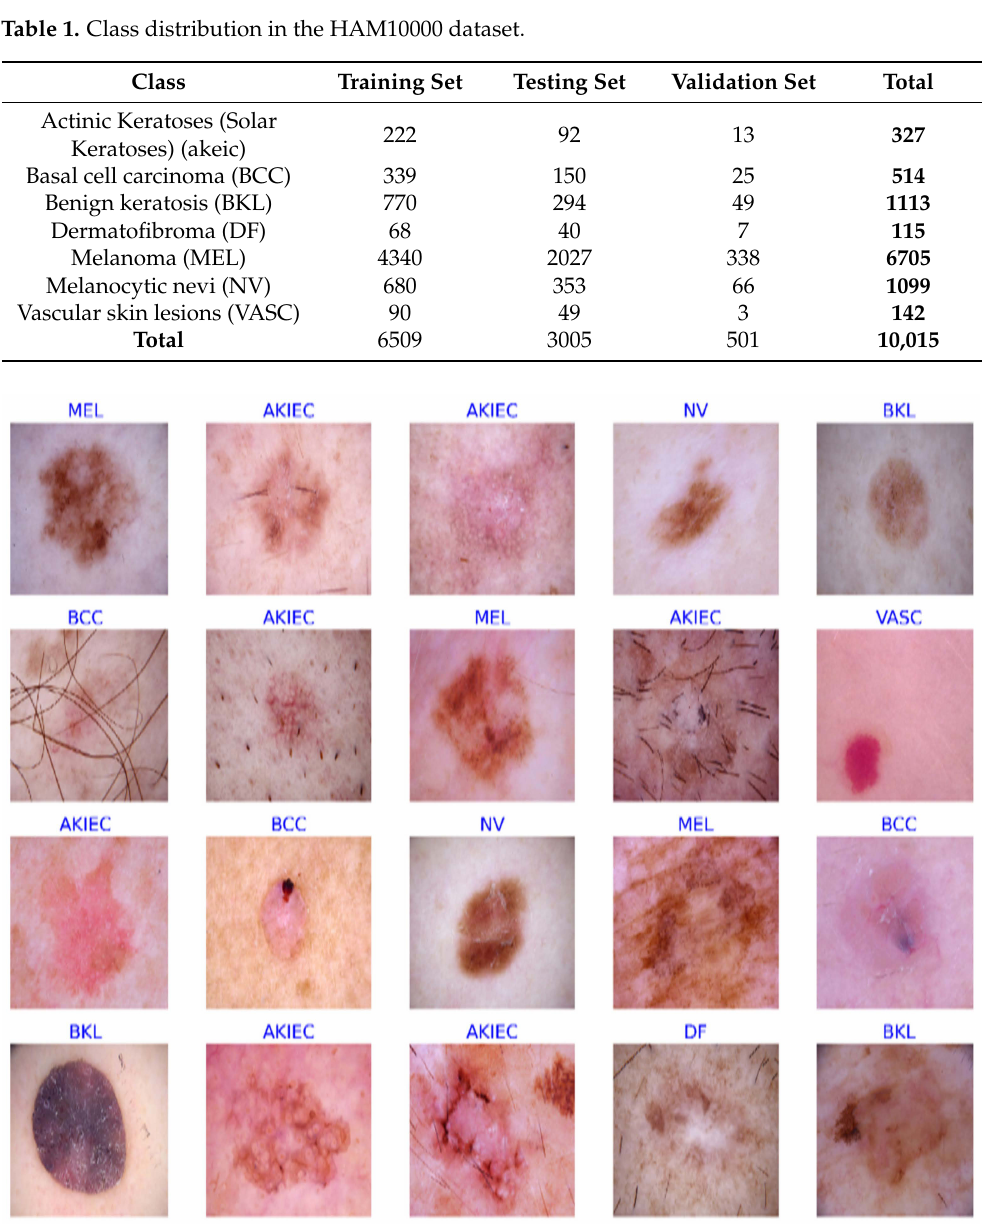
Figure 1. Samples for different skin disorders from the HAM10000